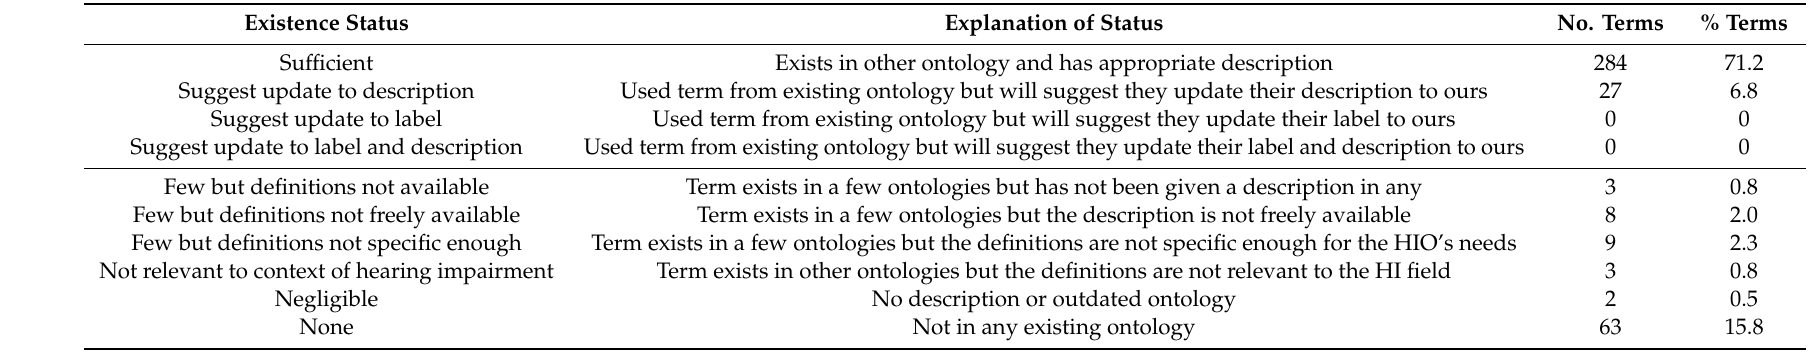
Table 1. Summary of terms’ existence statuses prior to inclusion in the HIO.